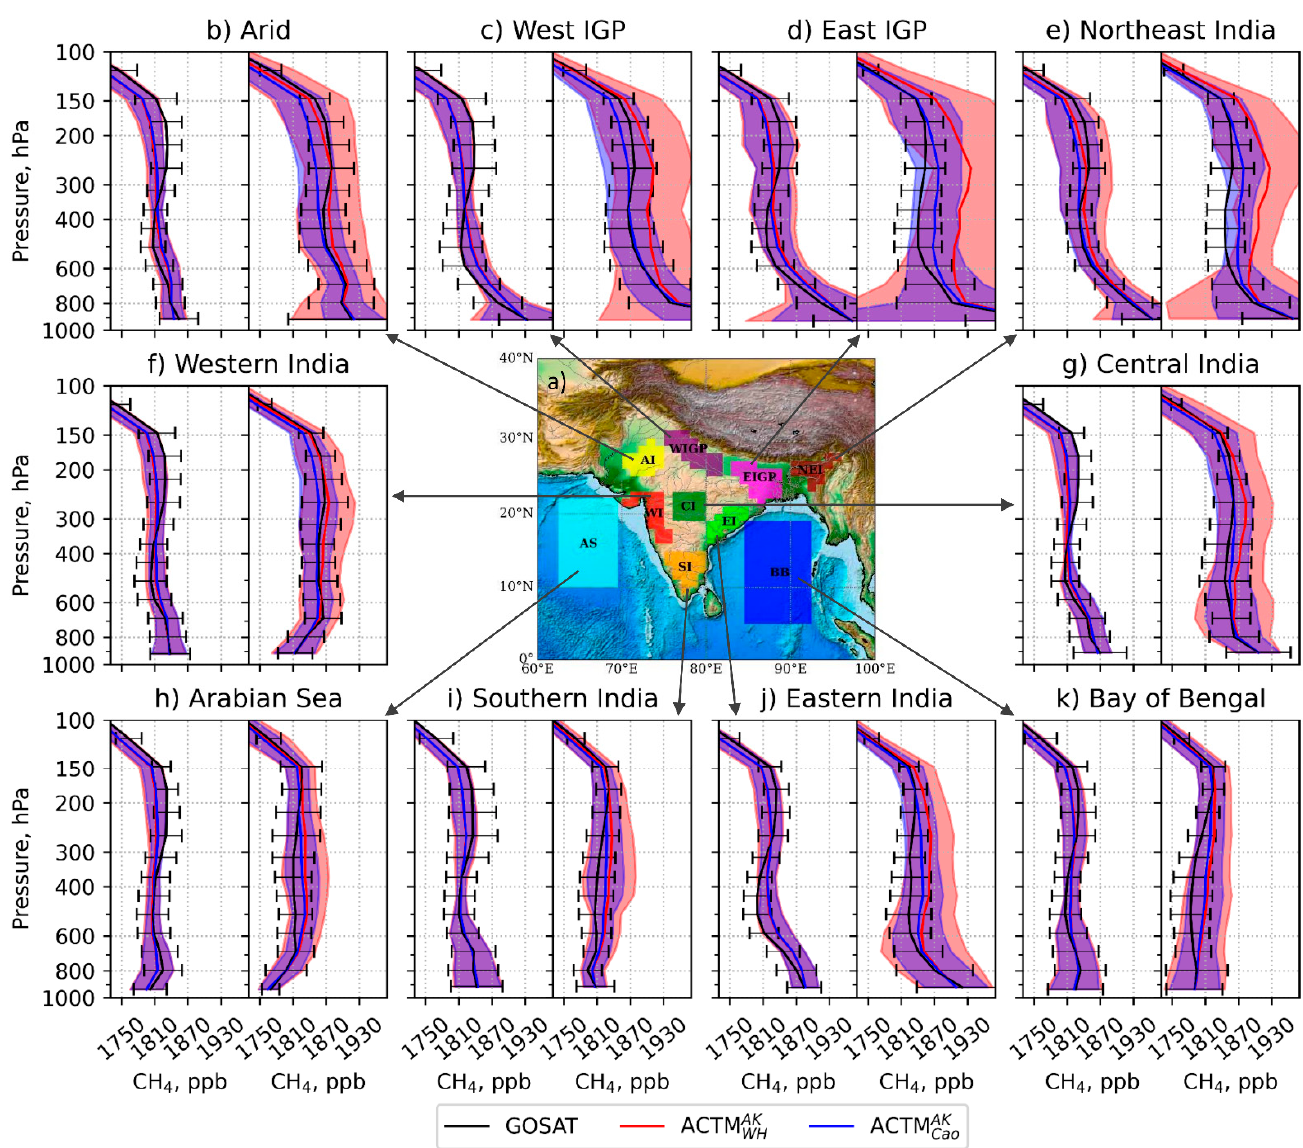
Figure 8. Seasonal mean CH 4 vertical profiles for pre-monsoon (April–June) and monsoon (July–September) of 2011 are shown in the left and right part of each panels ( b – k ) for the different regions as depicted in the central map ( a ). Black line with error bars shows the GOSAT-TIR data with 1- σ SD uncertainty. Blue and red lines with shaded areas correspond to the ACTM (cid:2887)(cid:2911)(cid:2925)(cid:2885)(cid:2895) and ACTM (cid:2907)(cid:2892)(cid:2885)(cid:2895) data with 1- σ SD uncertainty, respectively.